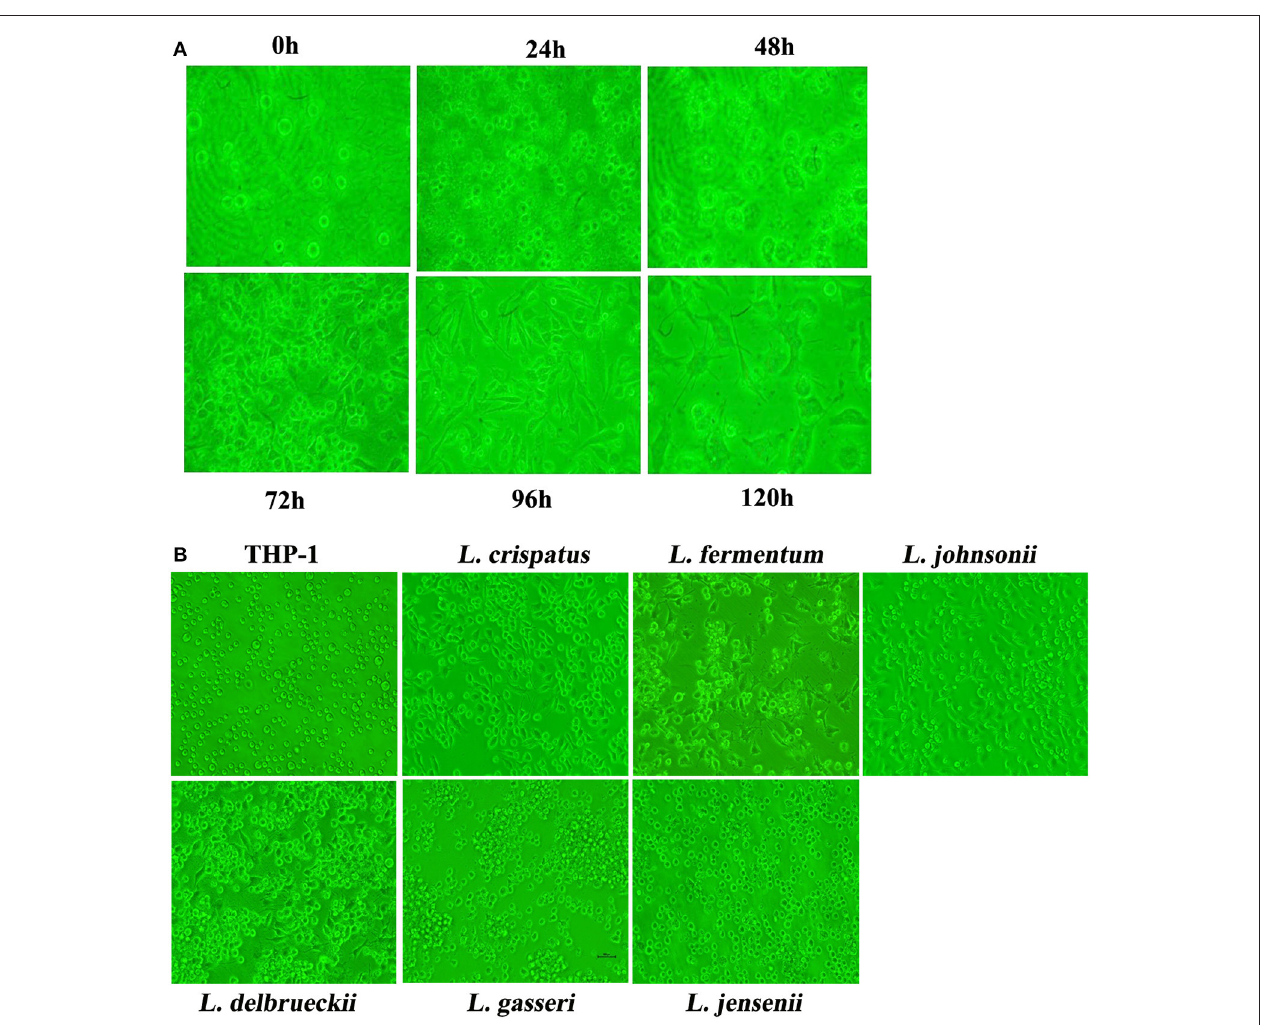
FIGURE 1 | Morphology of THP-1 after stimulation with lactobacilli. (A) Morphology of THP-1 after stimulation with L. crispatus. THP-1 was incubated with live L. crispatus (ratio = 1:500) for the indicated times. Inverted microscopy image of cells in culture at a magnification of 200 × is presented. (B) Morphology of THP-1 after stimulation with 6 species of Lactobacillus. THP-1 was incubated with different species of Lactobacillus ( L. crispatus, L. fermentum, L. jensenii, L. gasseri, L. delbrueckii 1, and L. johnsonii ) (ratio = 1:500) for 96h. Inverted microscopy image of cells in culture at a magnification of 200 × is presented.